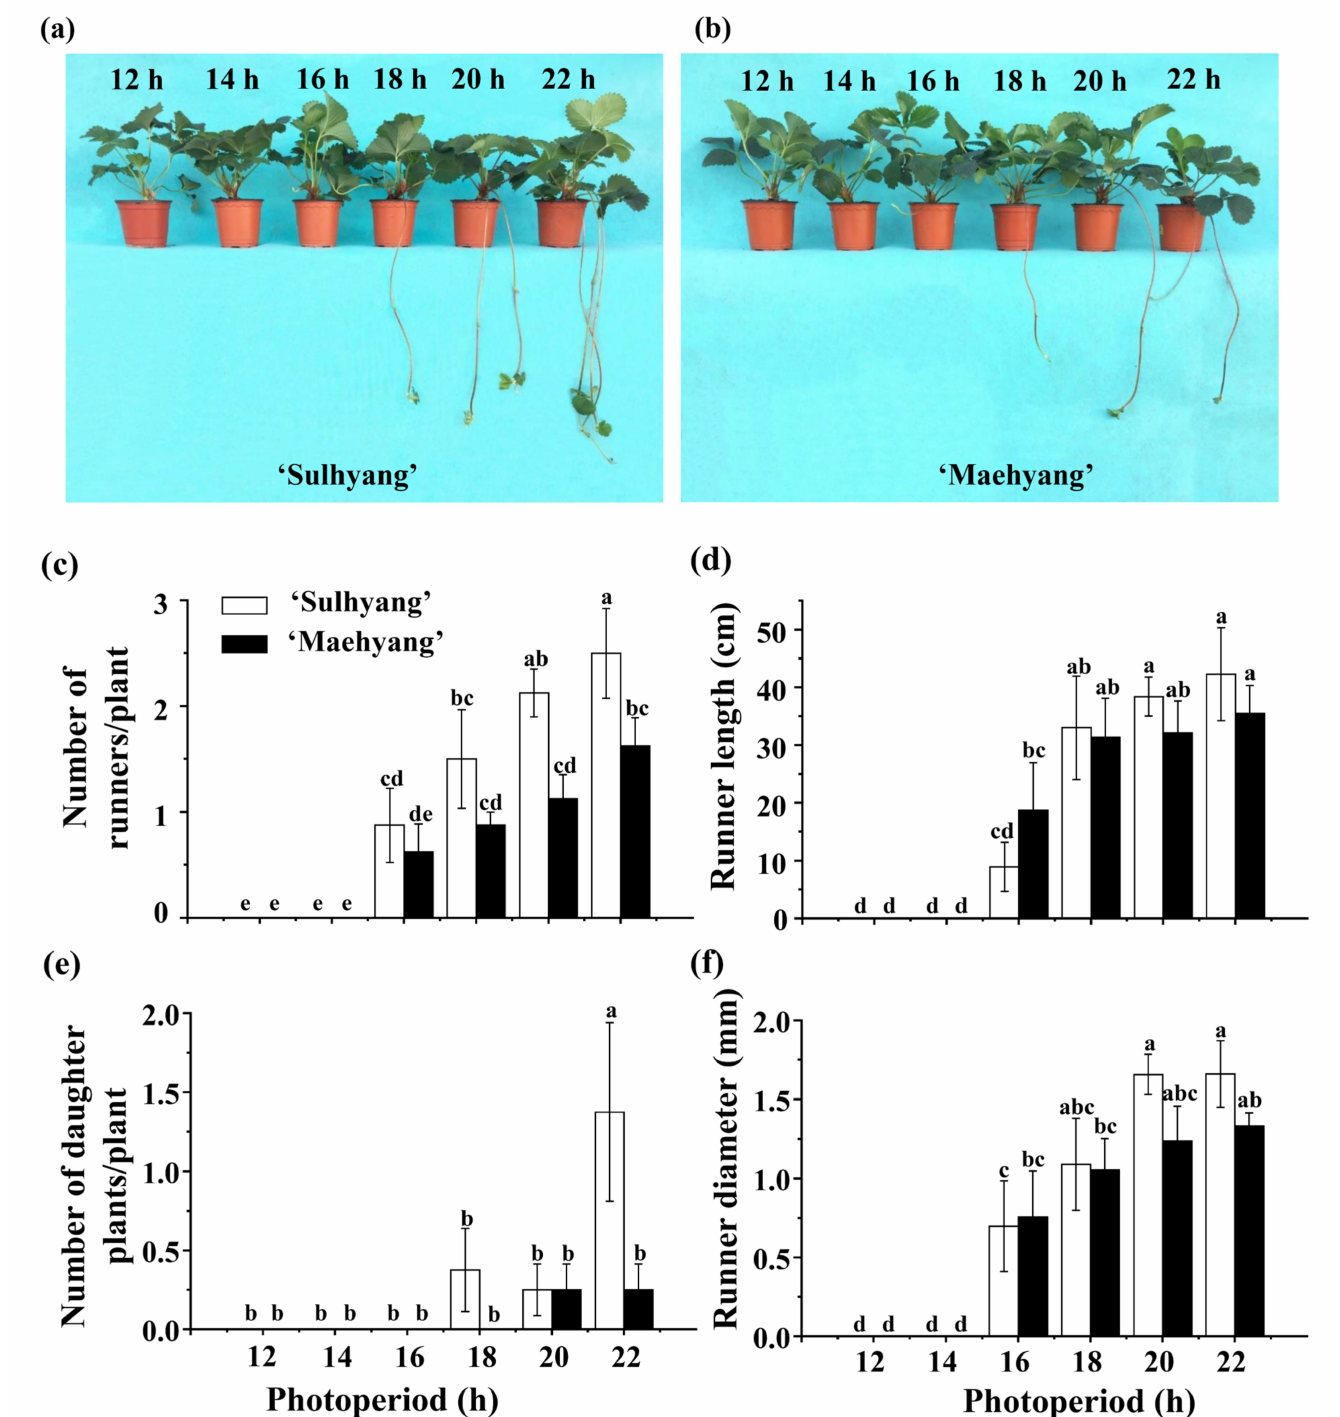
Figure 2. The morphology of strawberry plants ( a , b ) and runner-related parameters ( c – f ) as affected by the photoperiod. Lowercase letters indicate significant difference according to the Duncan’s multiple range test at a 0.05 level. Vertical bars indicate standard